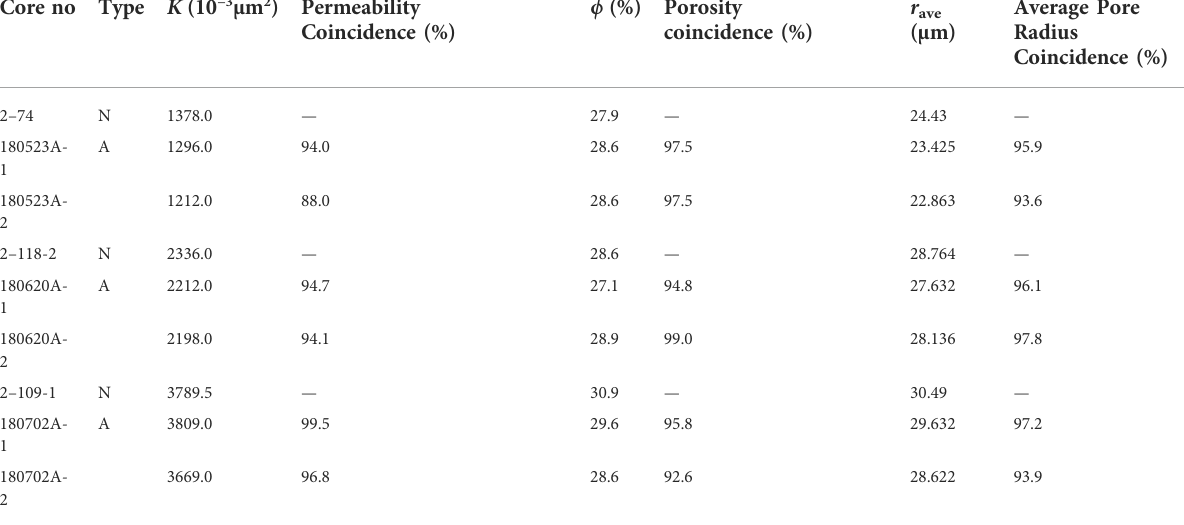
TABLE 3 Comparison of physical parameters between arti fi cial and natural cores.